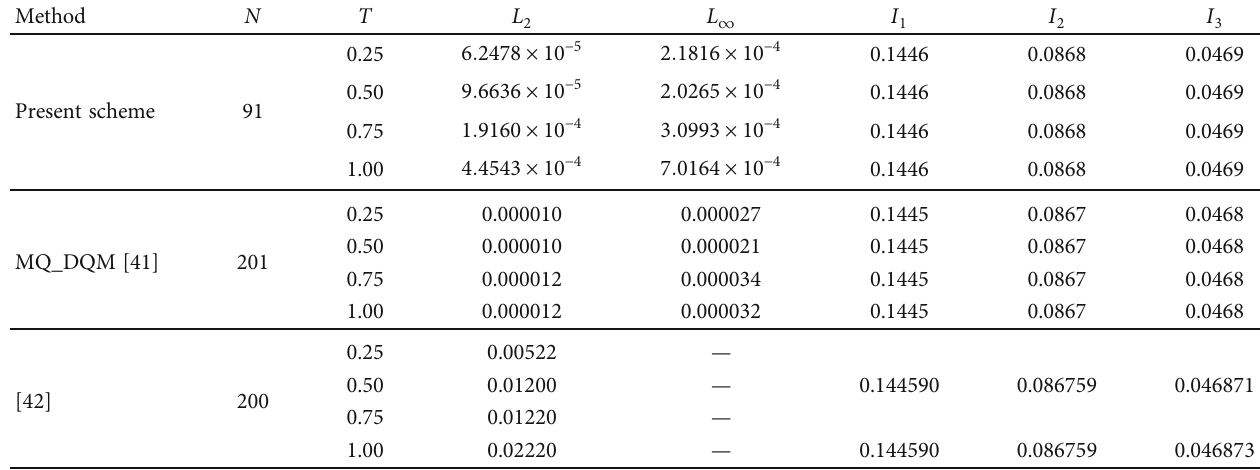
Table 3: Experimental evaluation of single soliton: Δ t = 0 : 001 :